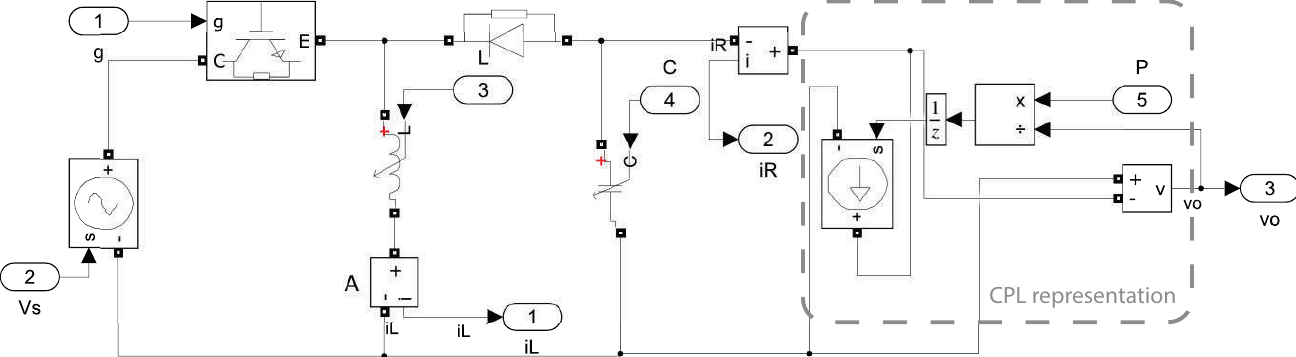
( b ) This figure represent the inside of the sub-system. There are a voltage source, inductance, capacitance and resistor, all of which are variables. Their values are given by an arbitrary external signal.